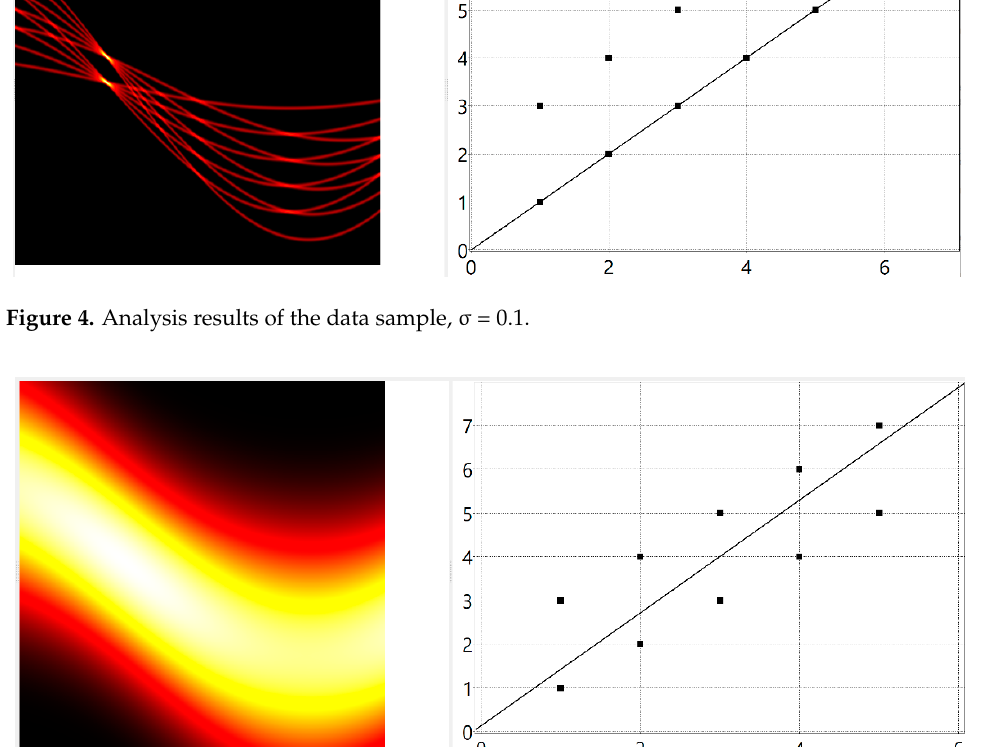
Figure 5. Analysis results of the data sample, σ = 5.